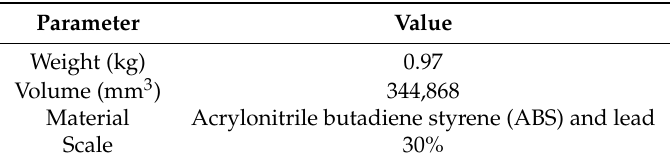
Table 2. Parameters of the model for the free decay